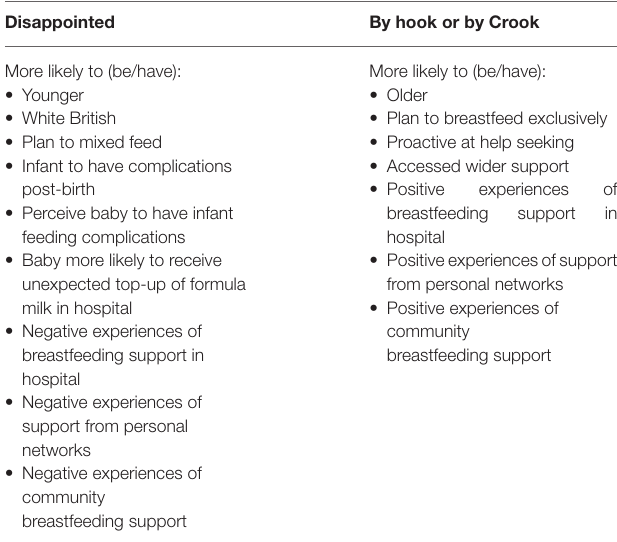
TABLE 4 | Summary profiles of the two typologies: “Disappointed” and “By book or by